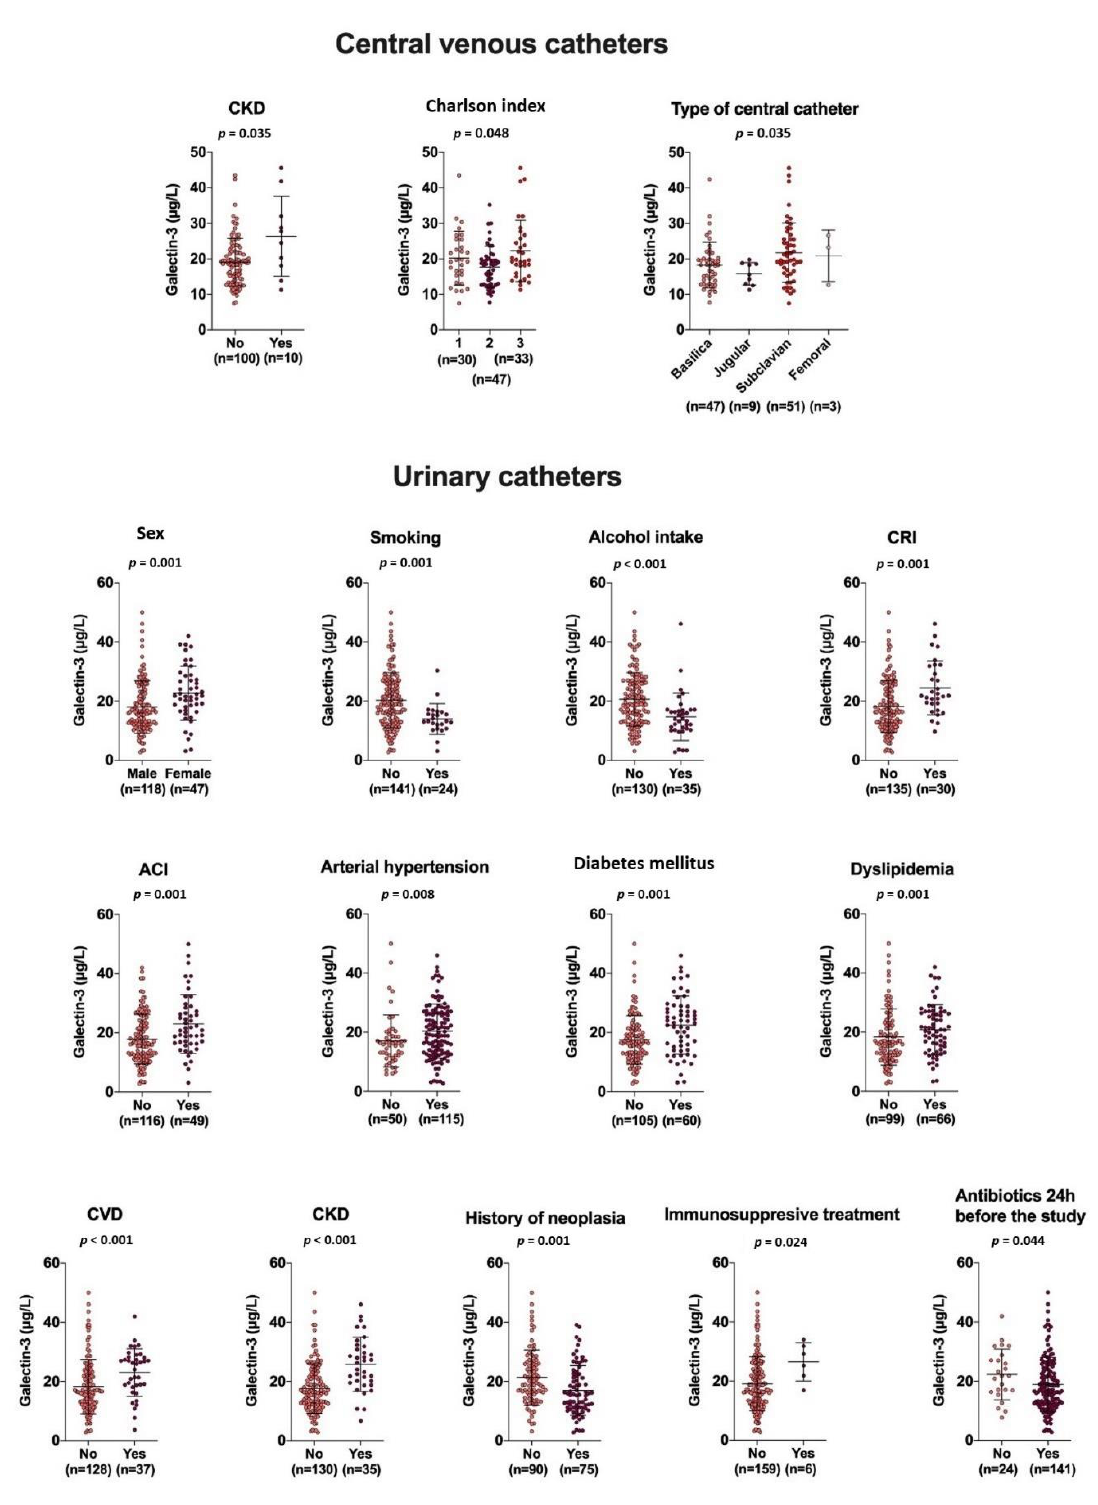
Figure 1. Influence of demographic and clinical variables on plasma galectin-3 concentrations in catheter-bearing patients. Statistical analyses used the χ 2 test or the Kruskal–Wallis test. CKD: chronic kidney disease; CRI: catheter-related infection; CVD: cardiovascular disease. In patients with a CVC, significant direct correlations were observed with age and the CRP and creatinine concentrations, and an inverse correlation with the number of days